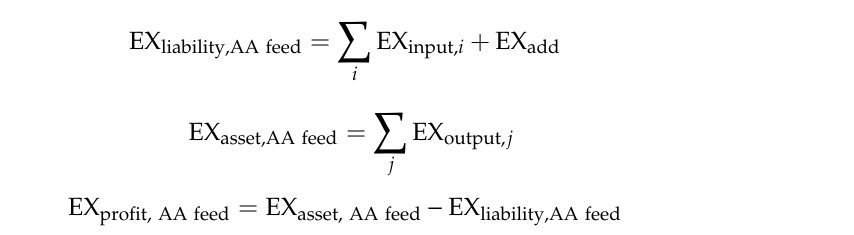
Figure 8. Exergy profit evaluation of inlet acetic acid stream.